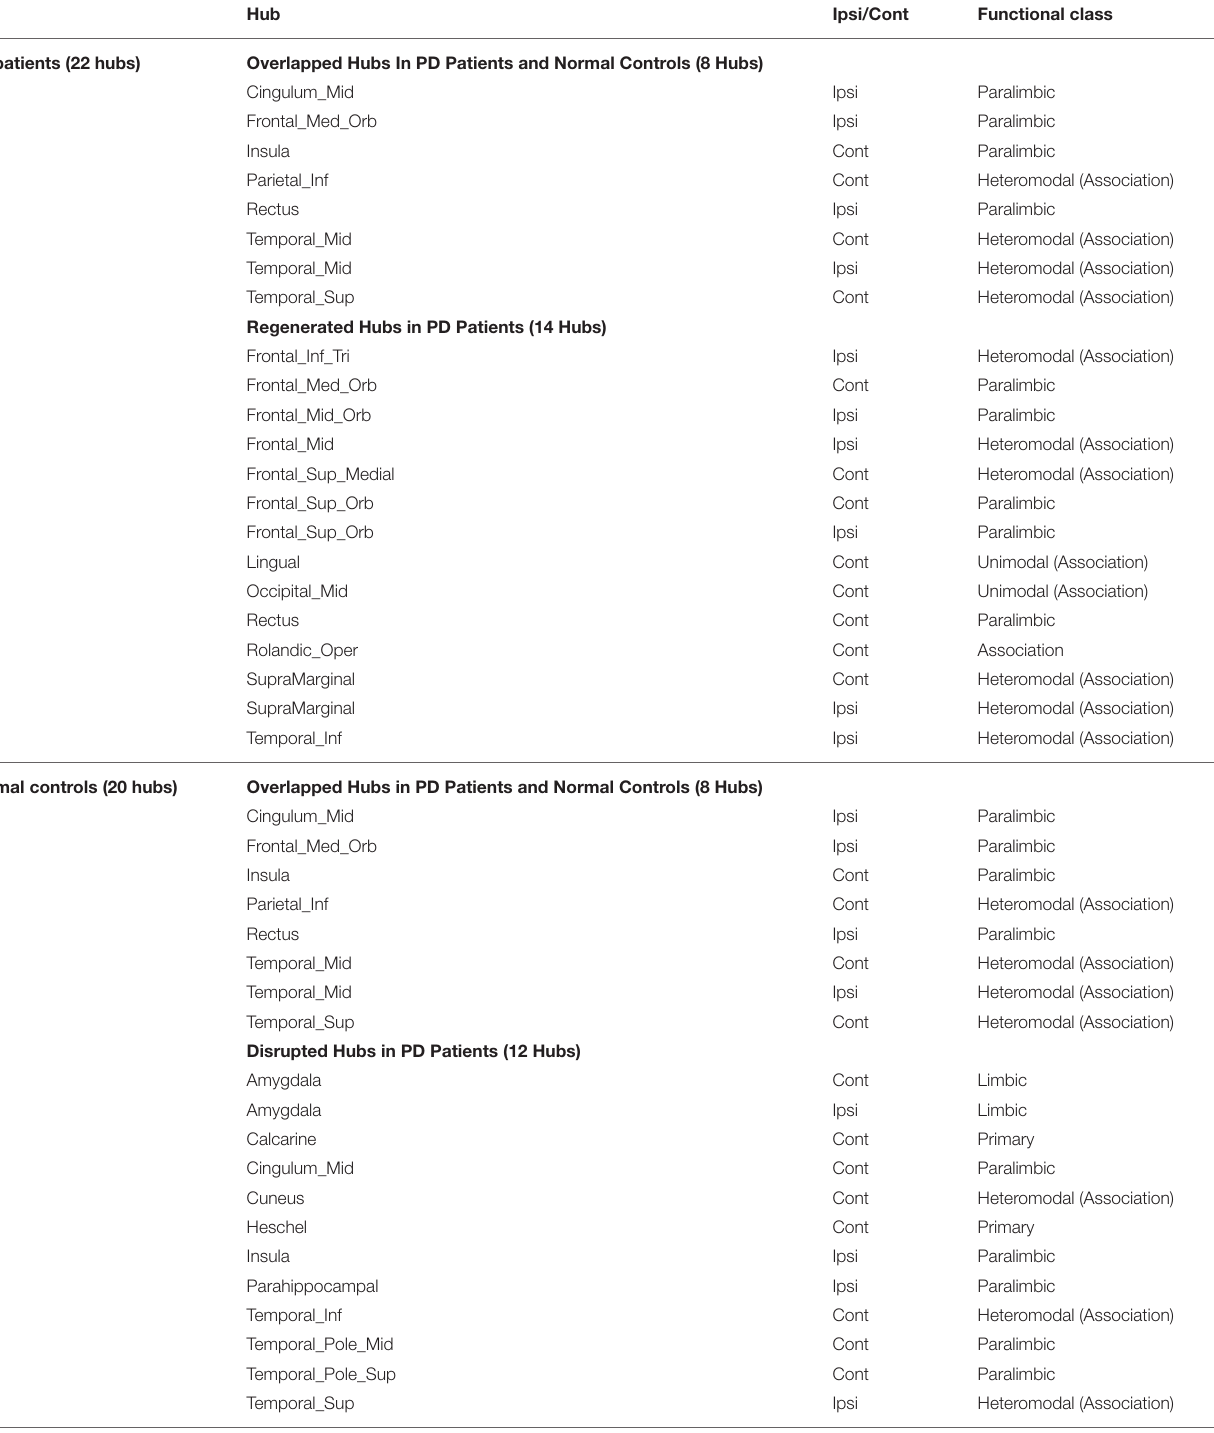
TABLE 4 | The hub distributions of PD patients and normal controls.